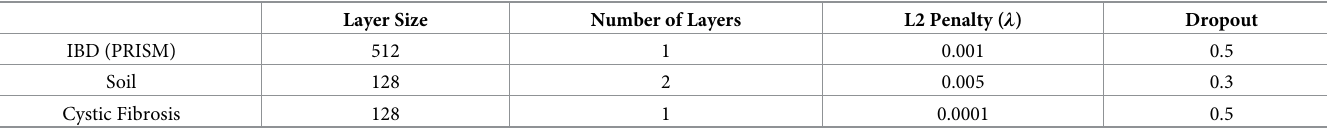
Table 3. The optimal hyper-parameters for the neural network model in each